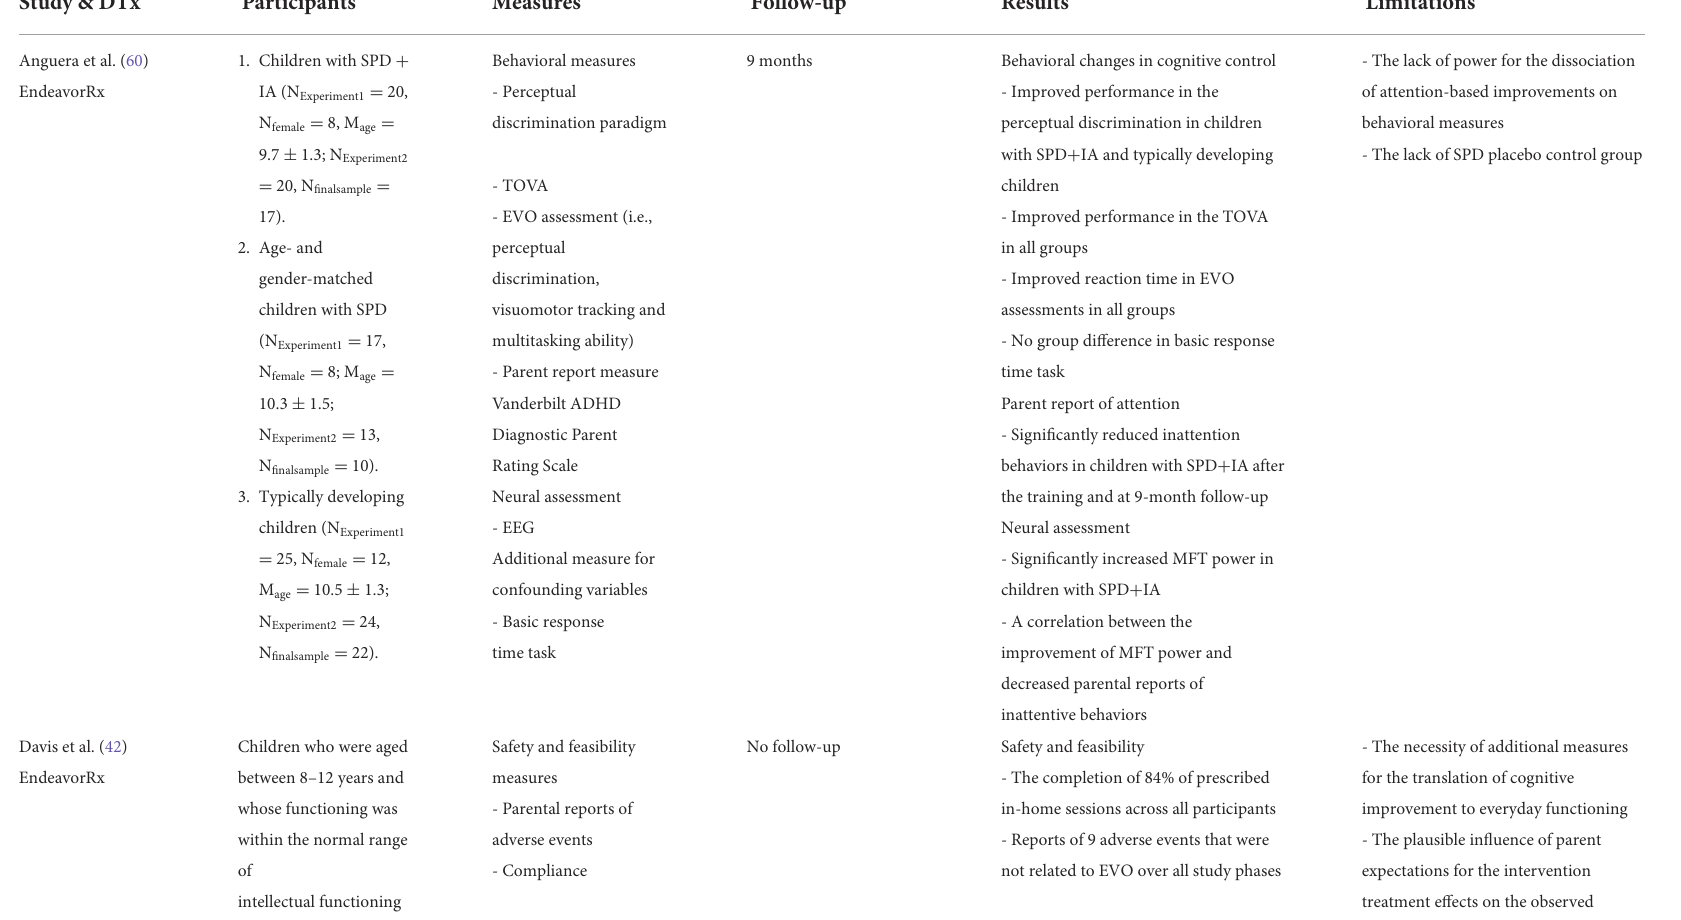
TABLE 2 The summary of 21 studies that examined the therapeutic effects of DTx for children and